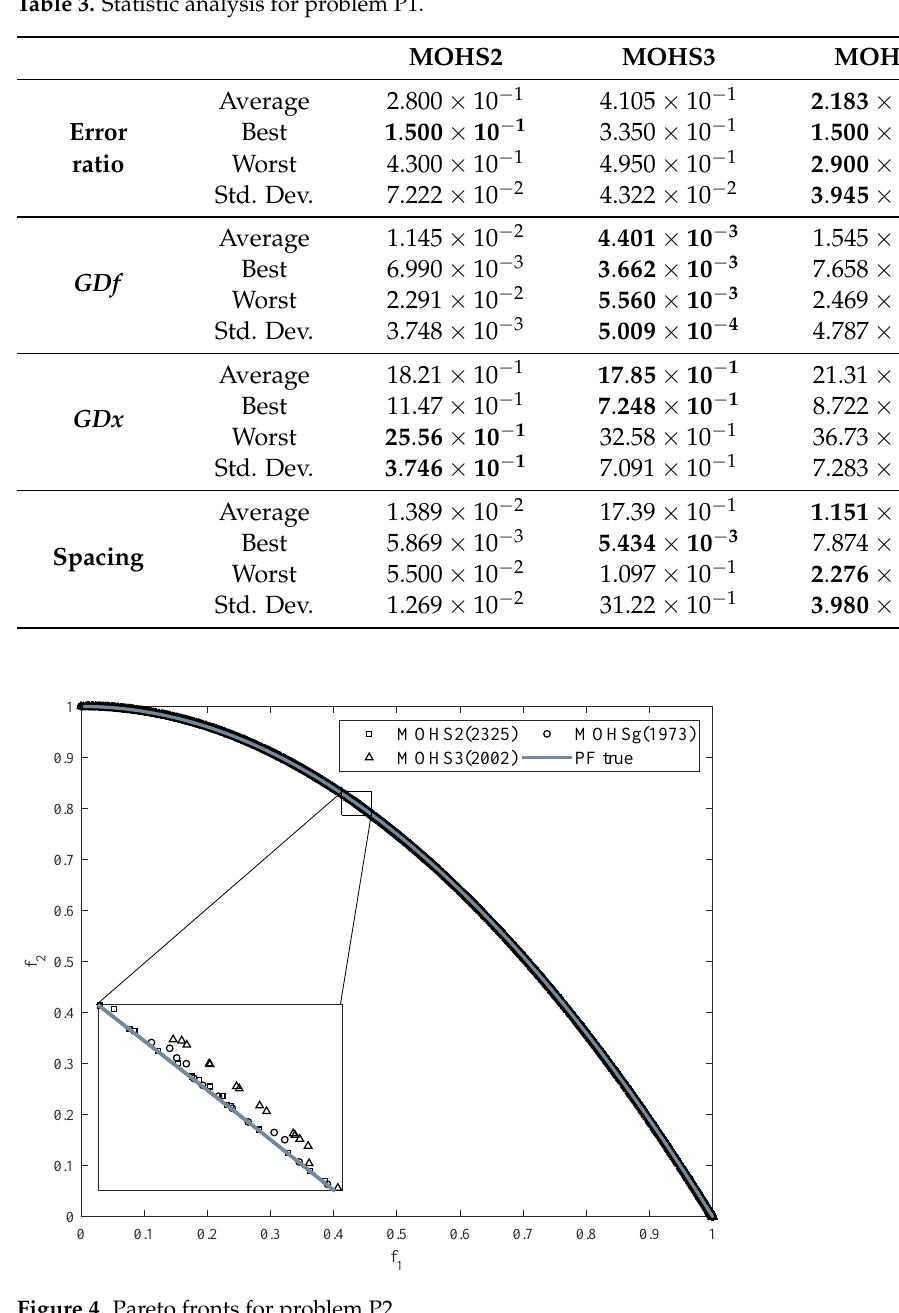
Figure 4. Pareto fronts for problem